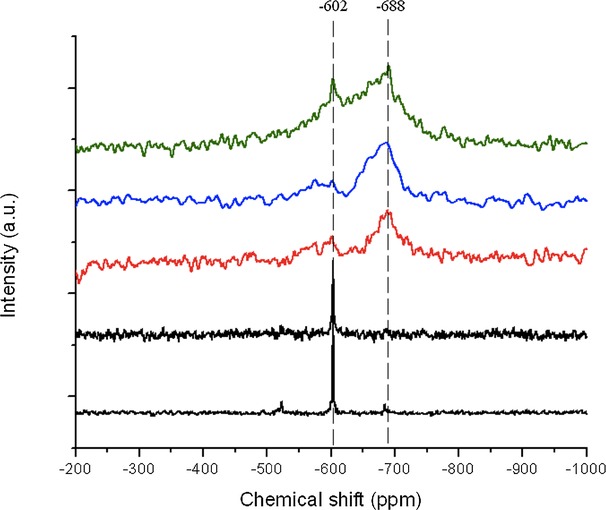
119Sn MAS NMR spectra of Sn-β samples containing 2 (red), 5 (blue), and 10 (green) wt % Sn. From bottom to top; bulk SnO2, 10 % Sn(O2)-β, 2 Sn-β, 5 Sn-β, and 10 Sn-β.